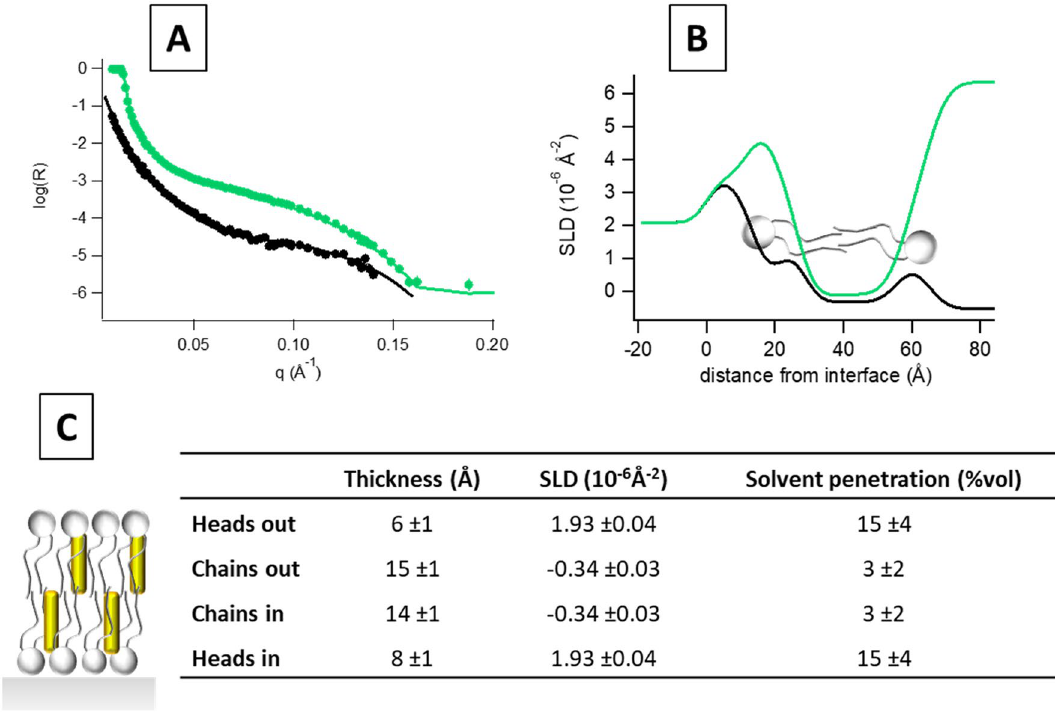
Figure 7. ( A ) reflectivity curves of the supported PLPC/sitosterol (80/20) membrane investigated in D 2 O (green) and H 2 O (black) at room temperature are shown. Symbols are the experimental points, lines the best fits from which the SLD profiles shown in panel ( B ) have been obtained with the software MOTOFIT 42,43 . ( C ) Common structural parameters used to contemporary fit the curves relative to the PLPC/sitosterol (80/20) in H 2 O and D 2 O at room temperature. Errors on the single values have been determined from the fit quality though the χ 2